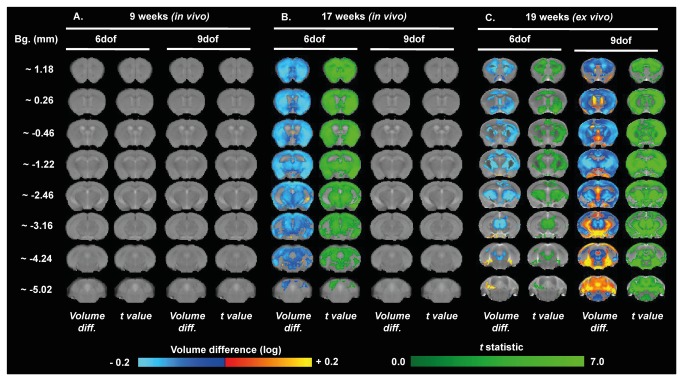
Brain volume changes in female WT and R6/1 assessed through TBM.Maps of local volumetric changes in female R6/1 mice compared to female WT 9 weeks in
vivo (A), 17 weeks in
vivo (B), and at 19 weeks ex
vivo (C). Images presented as either both global volume change (6 dof), or region-specific changes corrected for global change (9 dof). Color scales are for volume difference (Volume diff., blue-to-yellow), and the raw t statistical value at each voxel (dark-to-light green). Only volume changes and effects-sizes which survive multiple comparisons corrections across all voxels in the brain (False Discovery Rate with q<0.05) are shown.